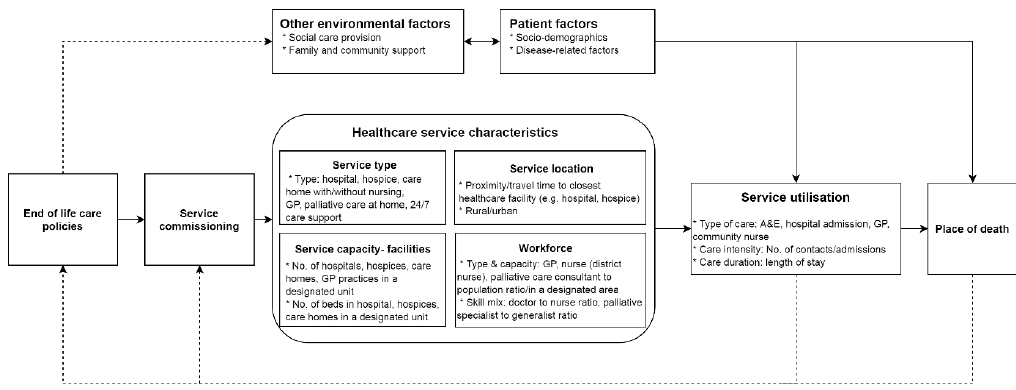
Figure 1. A conceptual framework for the role of healthcare service factors in place of death.